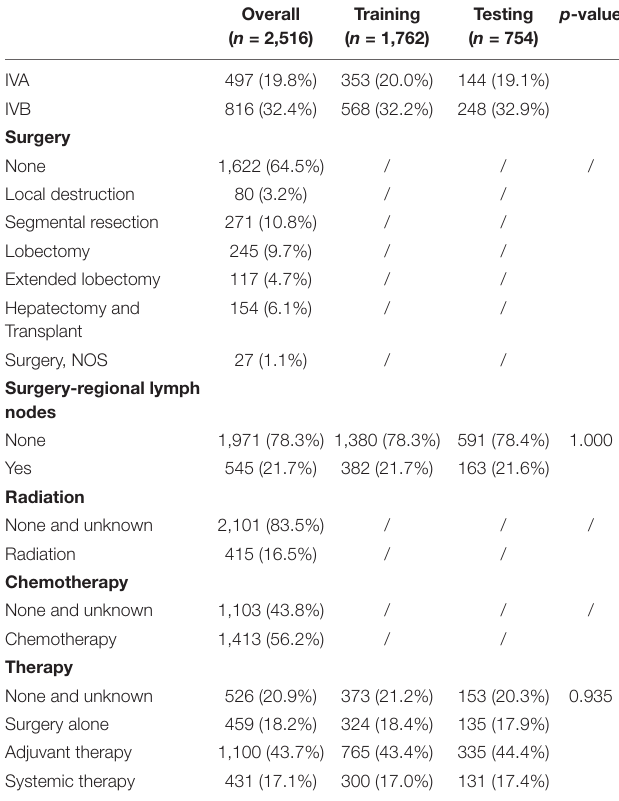
unmarried with domestic partners (60.7%). The proportions of male and female patients were approximately equal (49.9 vs. patients had moderately differentiated to poorly differentiated localized (stage groups I and II, 60.6%). Approximately one- third of patients had regional lymph node metastasis or distant metastasis at the time of diagnosis (30.8 and 32.4%). Most patients did not undergo any surgeries (64.5%), but more